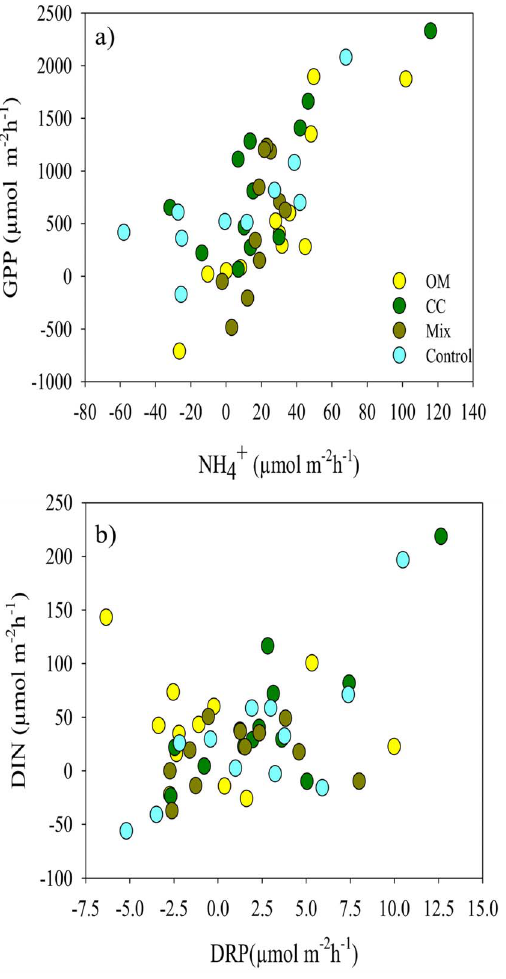
Figure 2. Relationship between main biogeochemical coupled processes (raw data). The top panel (a) shows the general relationship between gross primary production (GPP, m mol O 2 m 2 2 h 2 1 ) and ammonium uptake ( m mol NH 4 + -N m 2 2 h 2 1 ) across the sampling area. The bottom panel (b) shows the relationship between dissolved inorganic nitrogen uptake ( m mol DIN m 2 2 h 2 1 ) and dissolved reactive phosphorus ( m mol DRP m 2 2 h 2 1 ) across the sampling area. Treatments: Organic Matter, Calcium carbonate, Mix, Control.